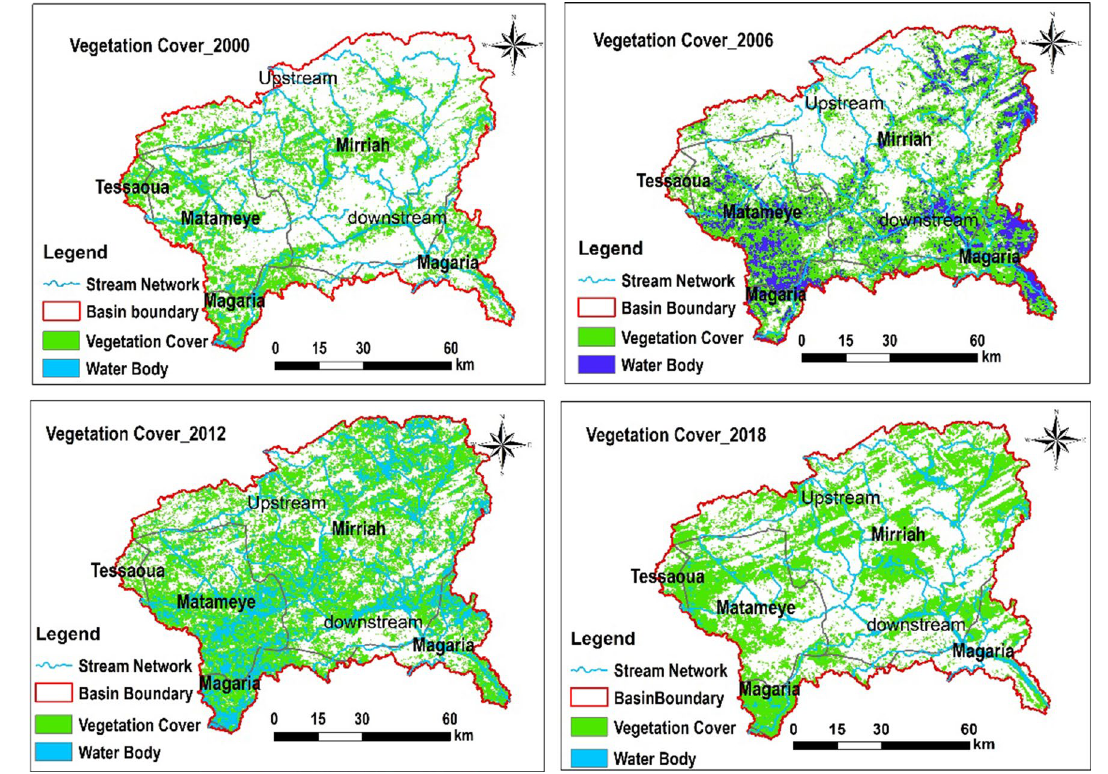
Fig. 5 Change in vegetation cover around the water body by different parts of the Korama basin. From 2000 to